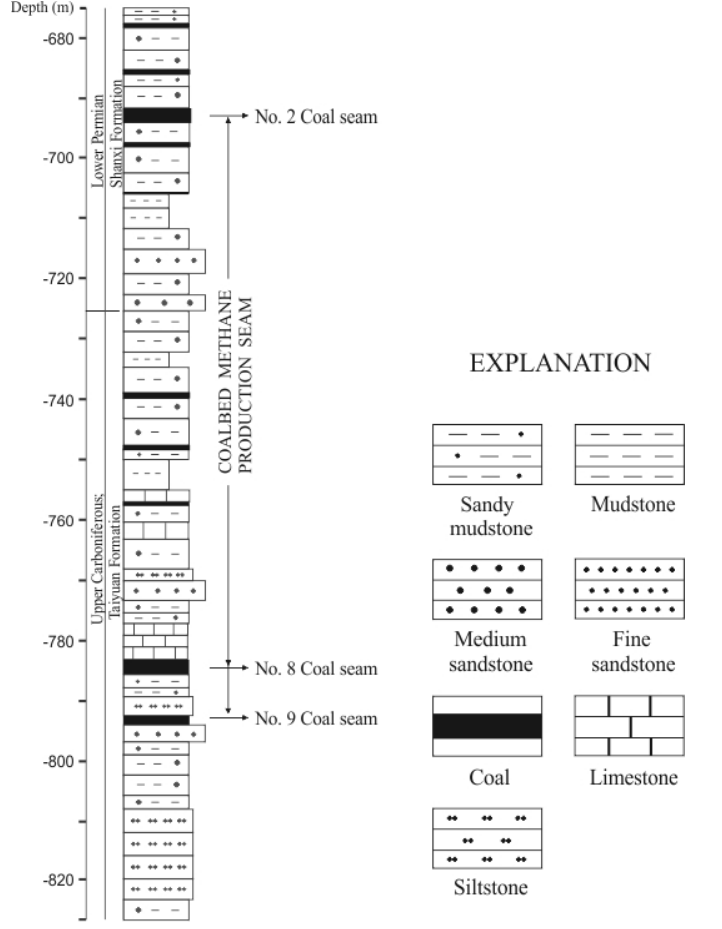
Figure 2. Lithology of the coal-bearing strata from Upper Carboniferous to Lower Permian in the Gujiao area.